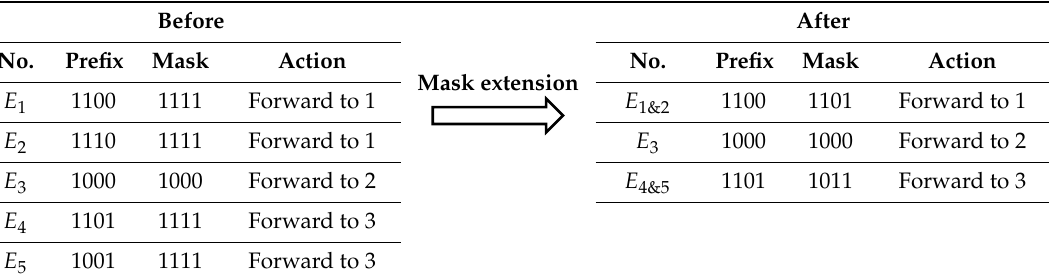
Table 2. An example of mask extension.